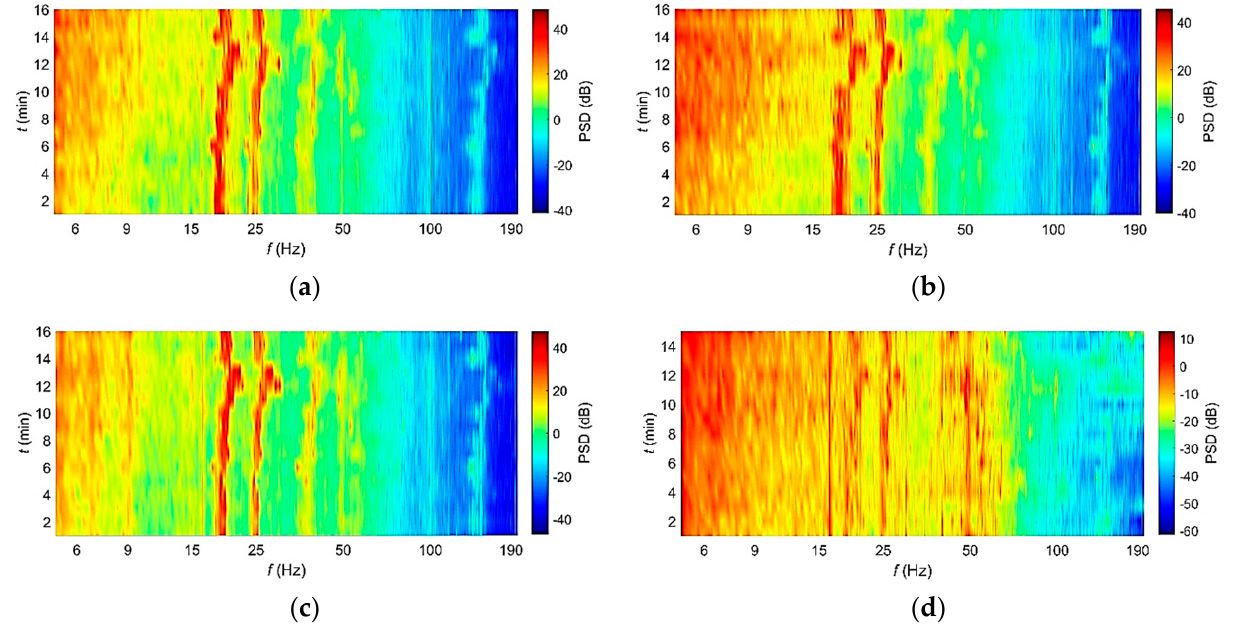
Figure 10. Examples of two-dimensional PSD distributions, within a 15 min interval, as gathered